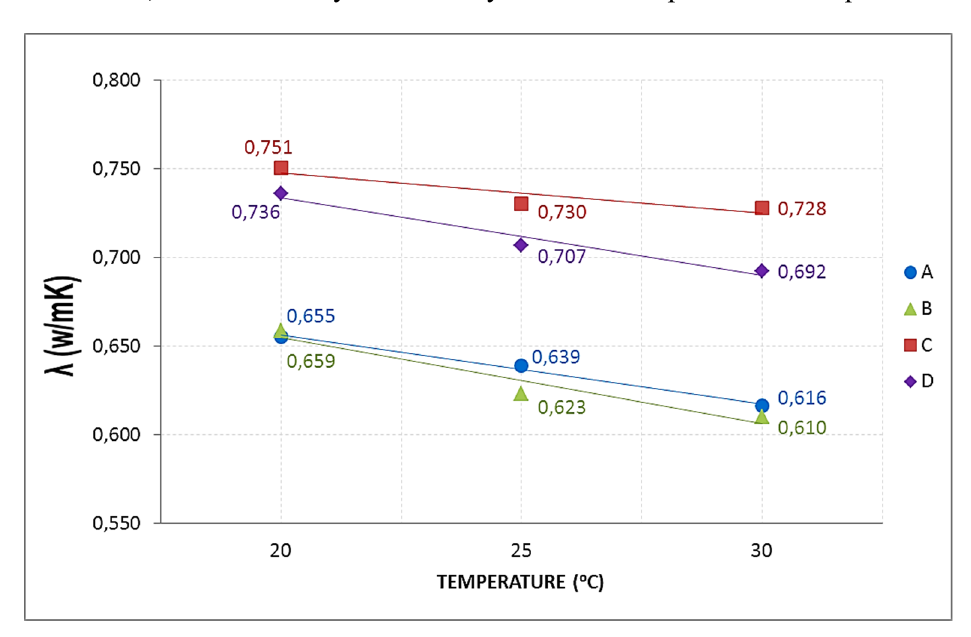
Figure 7. Influence of temperature on the thermal conductivity.